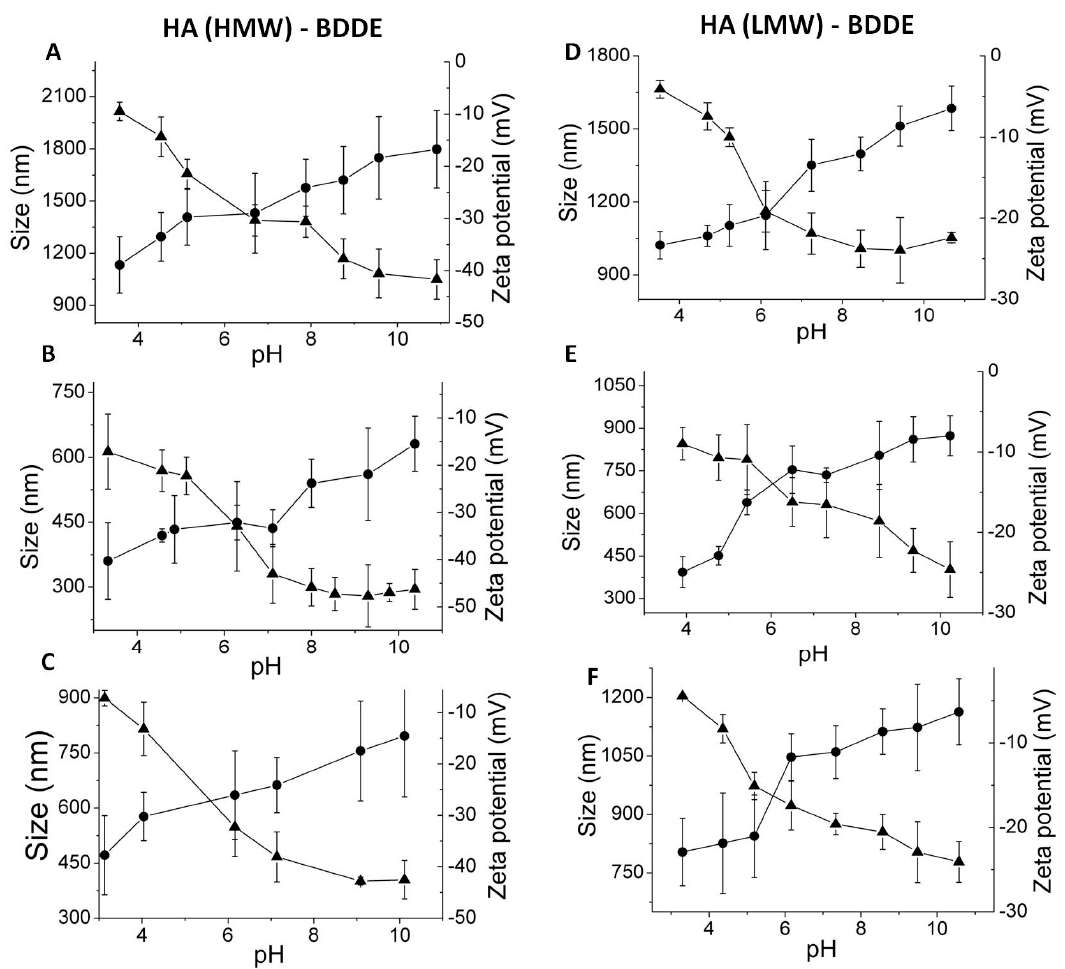
Figure 8. Hydrodynamic diameters ( ● ) and zeta potential ( ▲ ) as a function of external pH for HA nanogels obtained by the crosslinking of HA (high molecular weight) with BDDE at different ratios: ( A ) HA (HMW)–BDDE 1:0.2, ( B ) HA (HMW)–BDDE 1:1, and ( C ) HA (HMW)–BDDE 1:10 and obtained by crosslinking of HA (low molecular weight) with ( D ) HA (LMW)– = BDDE 1:0.2, ( E ) HA (LMW)–BDDE, and ( F ) HA (LMW)–BDDE 1:10. Table 1. Swelling degree (%) and crosslinking percentage of HA nanogels prepared with different initial molecular weights.